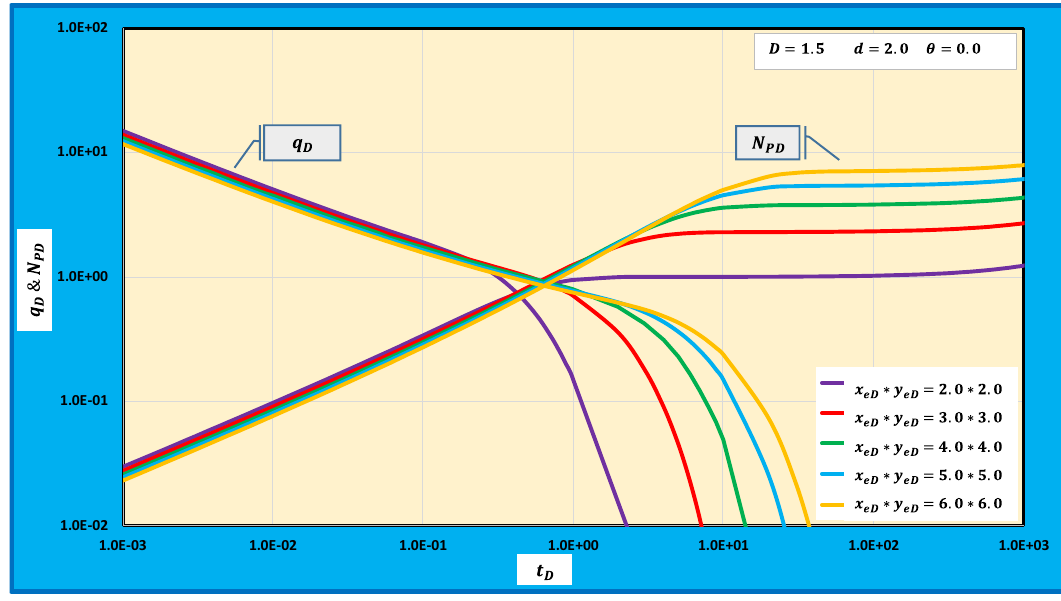
Fig. 14 Flow rate and cumulative production behaviors for different drainage areas ( 𝜃 = 0.0